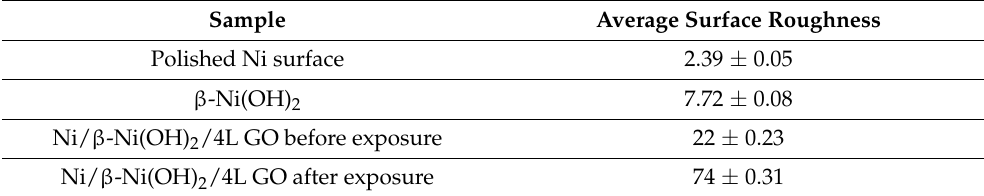
Table 1. Surface roughness of the examined surfaces determined from AFM.